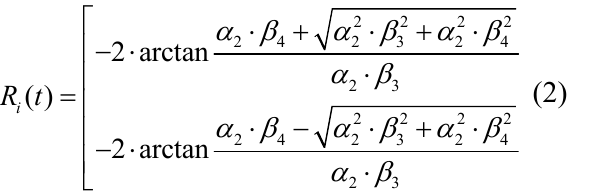
Table 2. Regressive statistics to define total expensesfunction specification at LLC “Turbomash” Factors Coefficients Standard margin